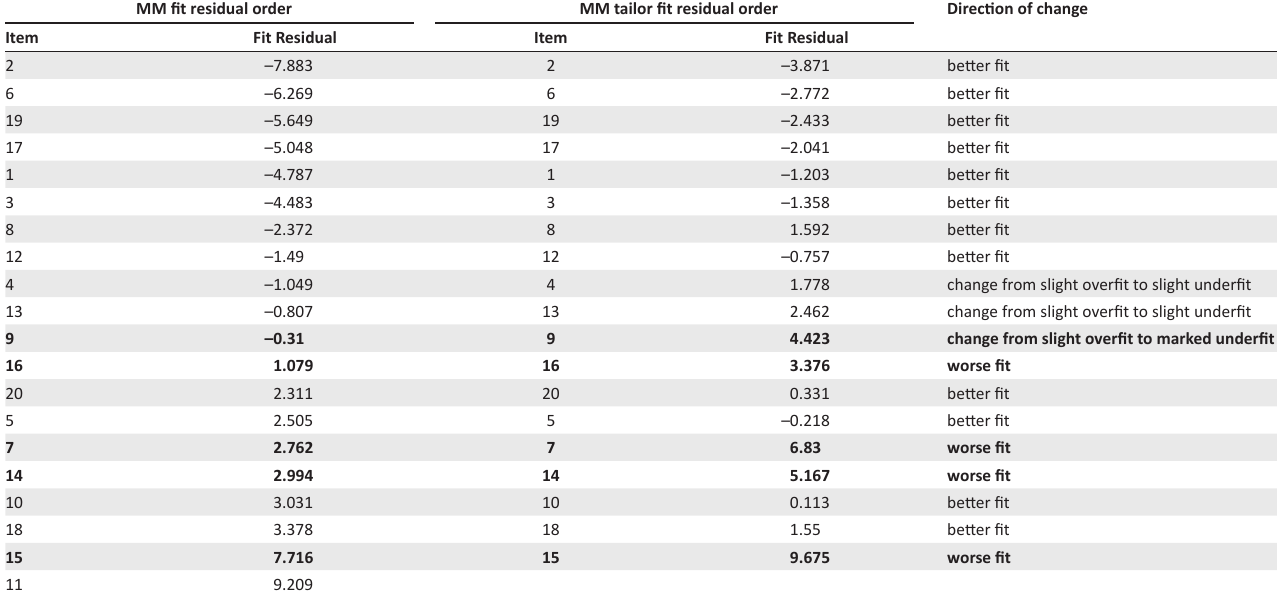
TABLE 9: Comparison of tailored analysis and MM case analysis from perspective of MM.